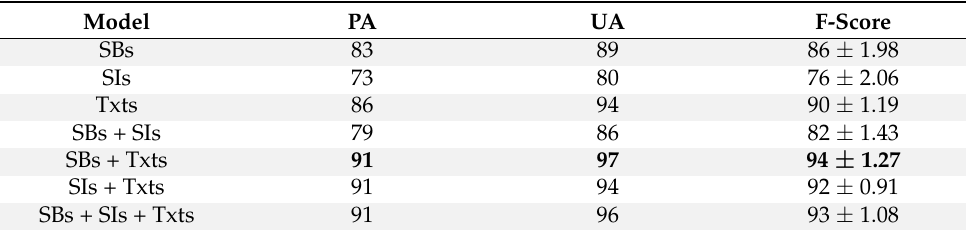
Table 3. Producer accuracy (%), user accuracy (%), average F-scores and standard deviation for different feature input models.